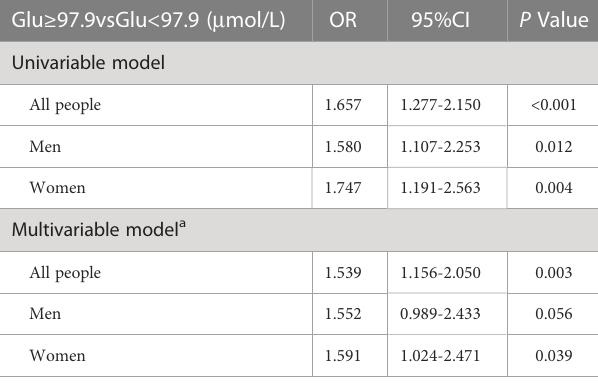
TABLE 3 Association between dichotomized Glu and CVD risk in patients with type 2 diabetes.